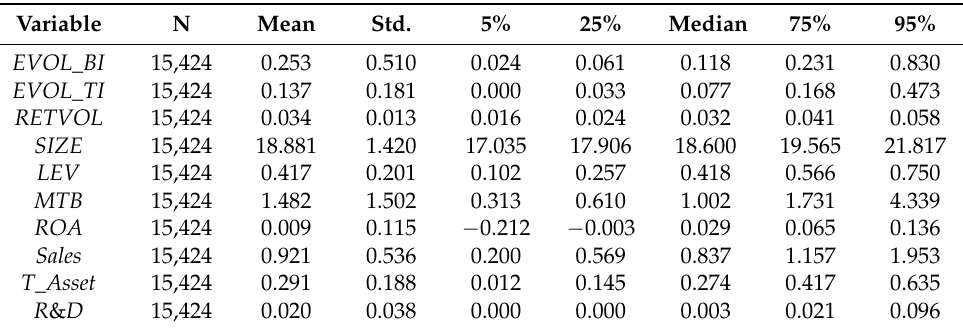
Table 1. The descriptive statistics.